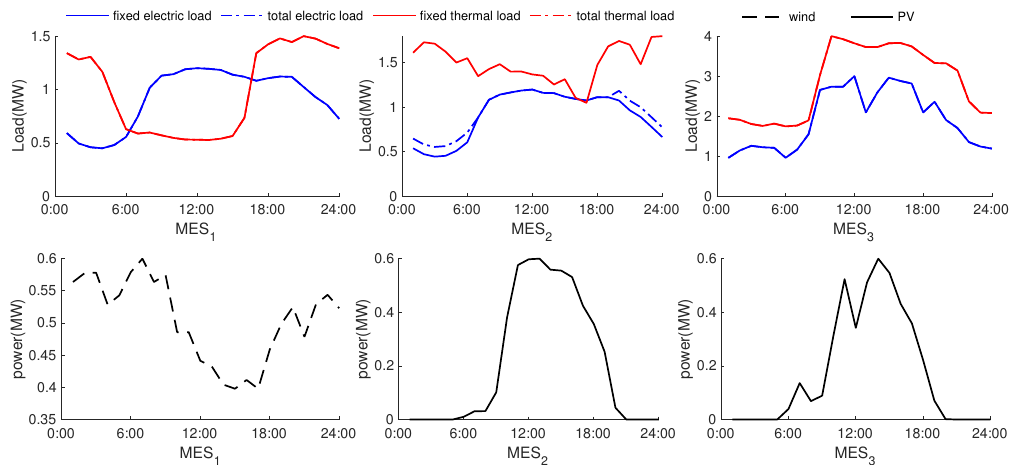
Figure 4. Curves of local loads and renewable energy sources (RES) in each MES.